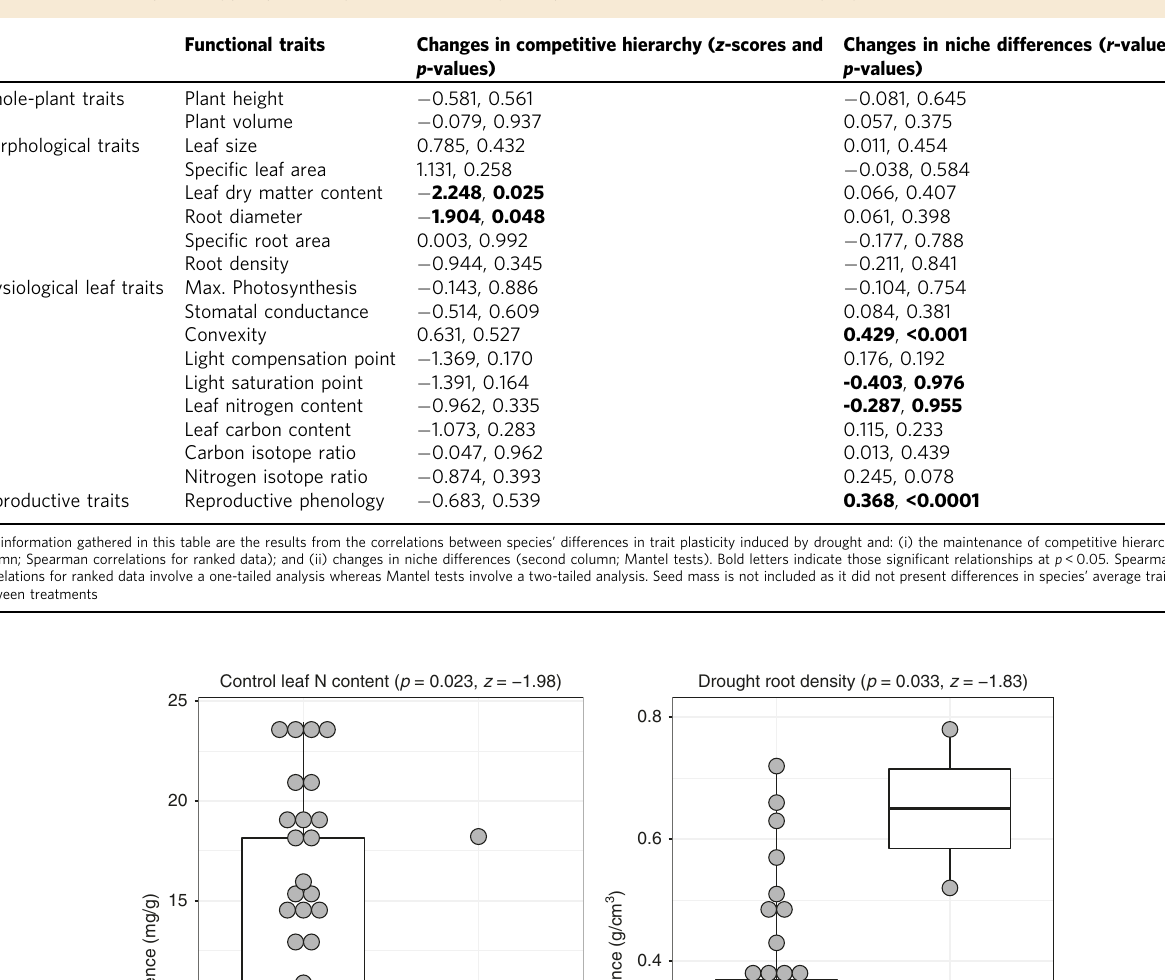
Changes in niche differences ( r -values and p -values)